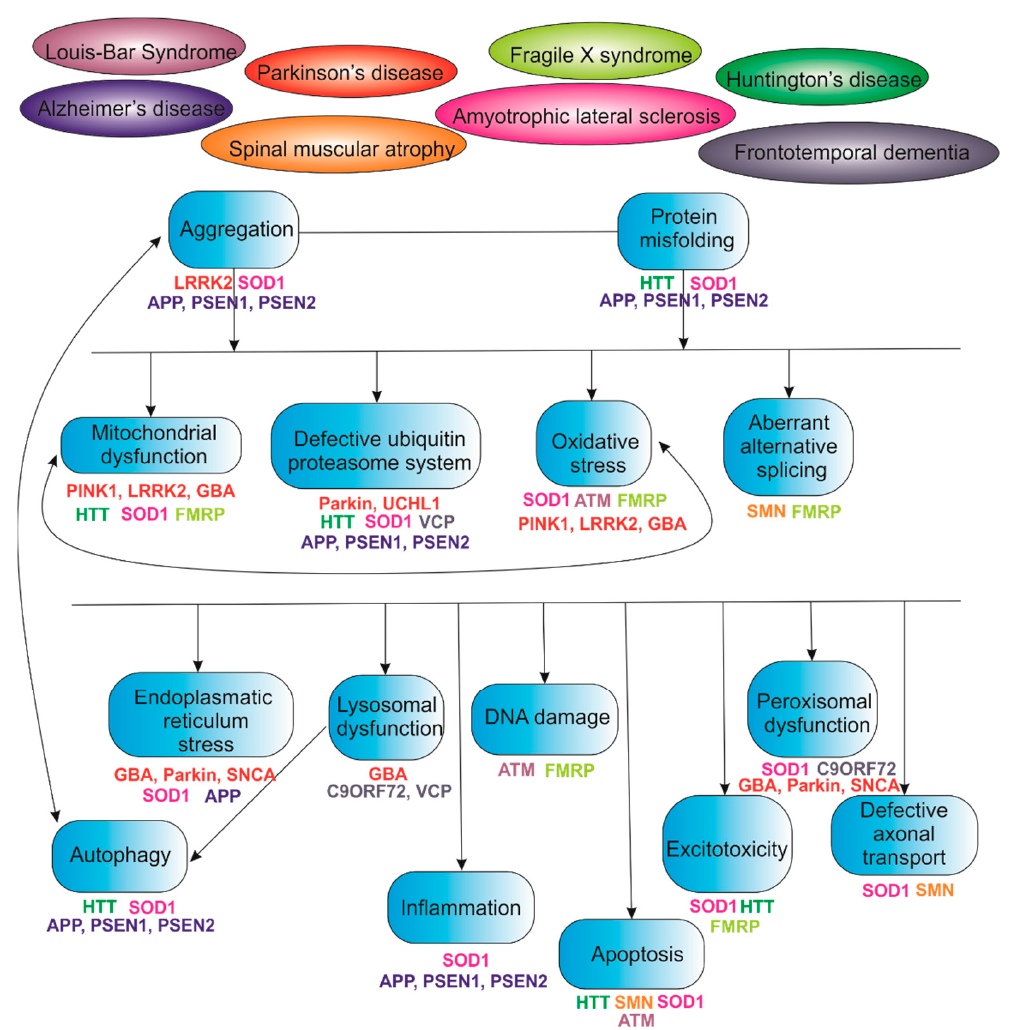
Figure 1. Universal pathological outputs in the hereditary diseases on the example of neurodegenerative diseases.